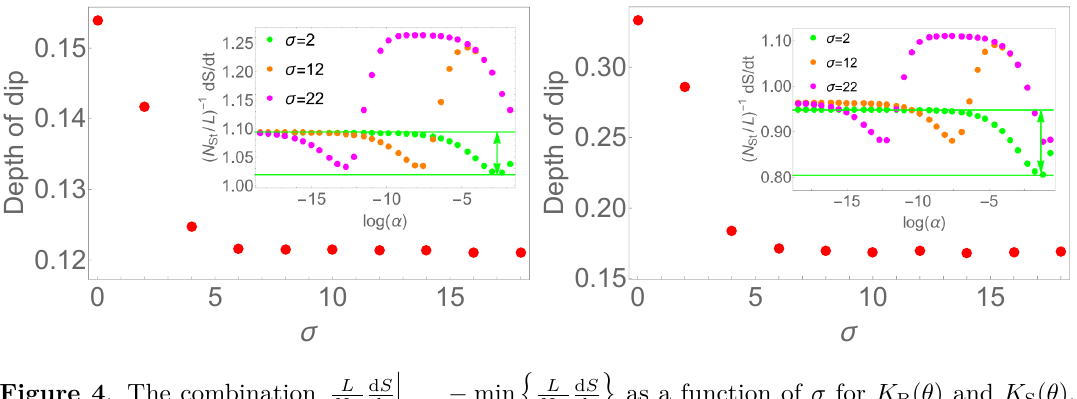
Figure 4 . The combination L This is a measure of the depletion of the normalised entropy production rate, defined as the difference between its value in the interacting regime (lower plateau in the inset) and its local minimum value (see the double arrowed segment in the inset). From both the main panels and the insets, we conclude that the depth of the minimum is larger for σ Ñ 0